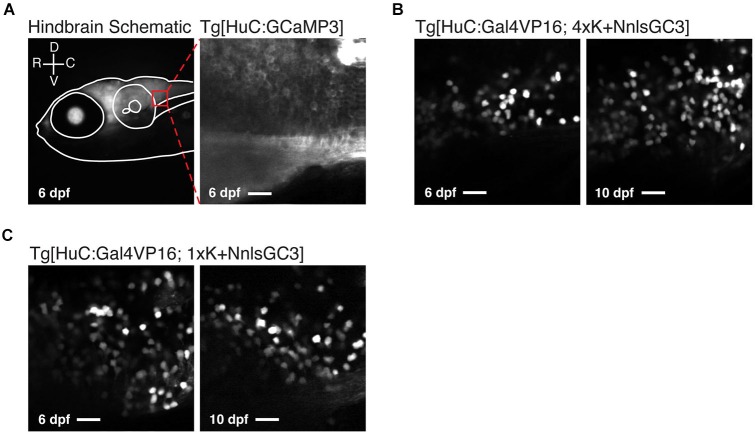
Tg[HuC:Gal4VP16; 1xK + NnlsGC3] larvae exhibit mosaic nuclear expression of GCaMP3. (A) Schematic of the 2PLSM imaging window in the caudal hindbrain (red box) overlaid on an epifluorescence image of a Tg[HuC:Gal4VP16; 1xK + NnlsGC3] taken at 6 dpf (left panel). Example 2PLSM fluorescence image of non-mosaic, dense cytoplasmic GCaMP3 expression in the caudal hindbrain of a Tg[HuC:GCaMP3] larva taken at 6 dpf (right panel). Scale bar represents 18 μm. (B, C) 2PLSM fluorescence images of the caudal hindbrain in Tg[HuC:Gal4VP16; 4xK + NnlsGC3] and Tg[HuC:Gal4VP16; 1xK + NnlsGC3] at 6 and 10 dpf. In (B) and (C), highly mosaic expression of nuclear-localized GCaMP3 in Tg[HuC:Gal4VP16; 4xK + NnlsGC3] and Tg[HuC:Gal4VP16; 1xK + NnlsGC3] is evident. Scale bars represent 18 μm.